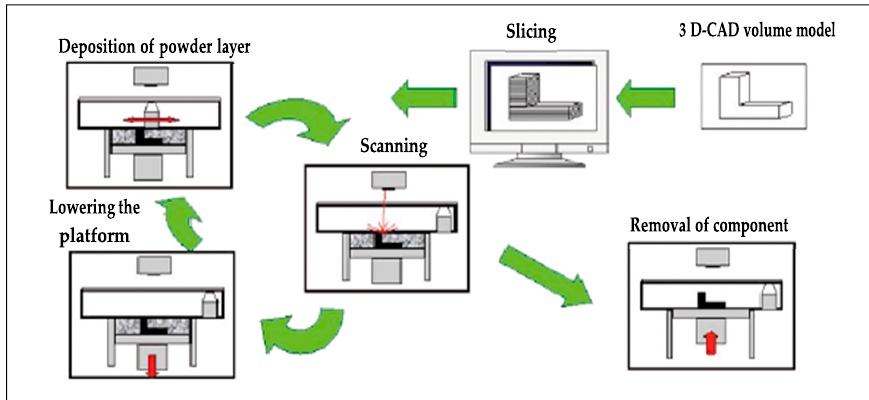
Figure 1. Principle of the SLM process [7]. Table 1. Common metal 3D printing